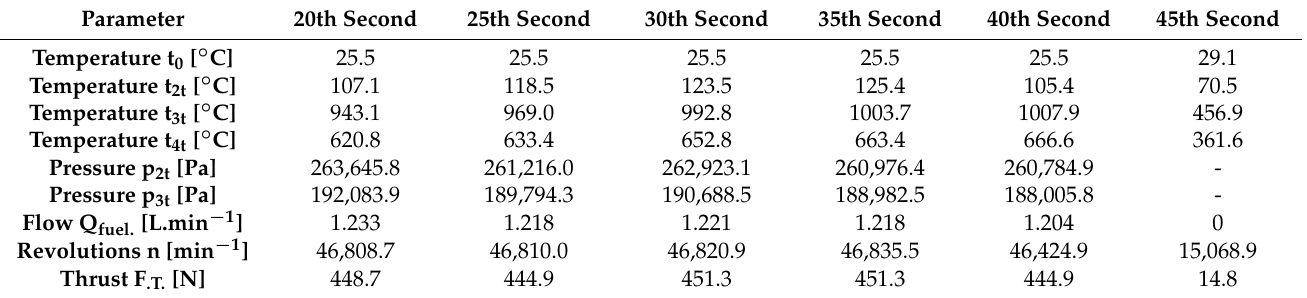
Figure 5. Graphic course of changes in SJE-20 parameters when using a mixture of 90% Jet A-1 avi- ation kerosene and 10% FAME biofuel.